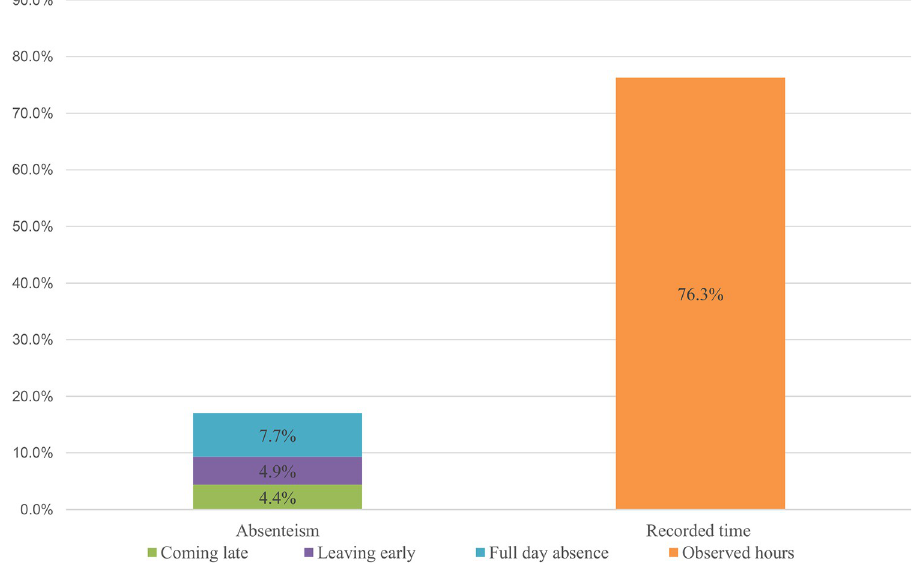
Fig 1. Percentage of observed time and percentage of lost time (not recorded) related to working